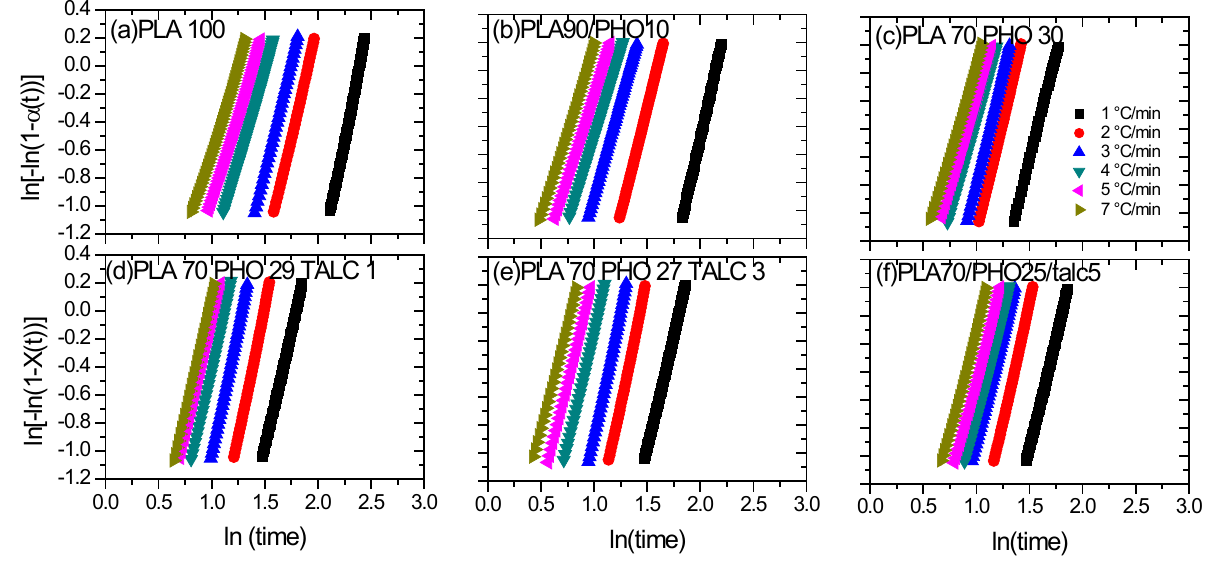
Figure 4: Typical Avrami plots of ln[-ln(1-α (t))] versus ln (time) at different heating rates and